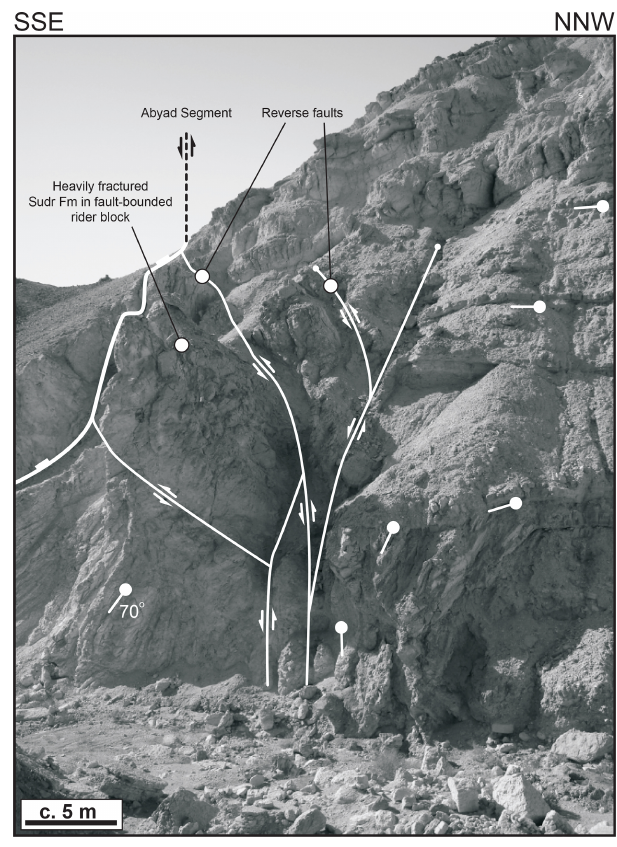
Figure 11. Photograph showing the structure of a “secondary” nor- mal fault zone associated with the Hadahid Fault System. The loca- tion of the photograph is shown in Fig.